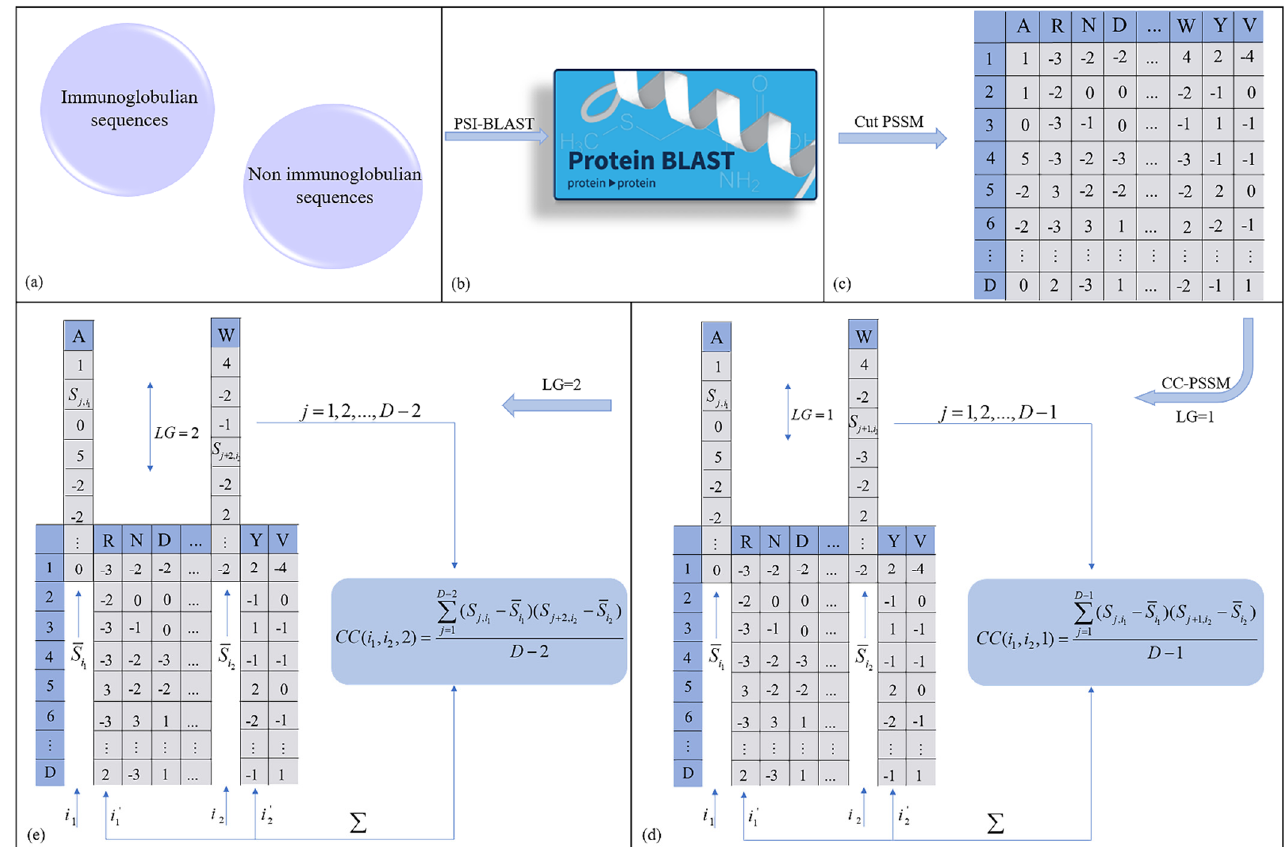
Figure 2. The calculation process of each protein sequence represented by CC–PSSM was described. ( a ) Use immunoglobulin and non immunoglobulin sequences as input. ( b ) Sequence alignment of the input data through the PSI–BLAST database. ( c ) The first 20 columns of alignment information were intercepted to obtain the PSSM matrix corresponding to each protein. ( d ) CC was calculated for each PSSM matrix, and lag = 2 was set. First, the eigenvector of 380 length when LG = 1 was obtained. ( e ) Then each PSSM matrix was calculated with the CC when LG = 2, and the eigenvector of length 380 is obtained. Finally, when lag = 2, each protein sample will be converted into a vector of length 760 after calculation.